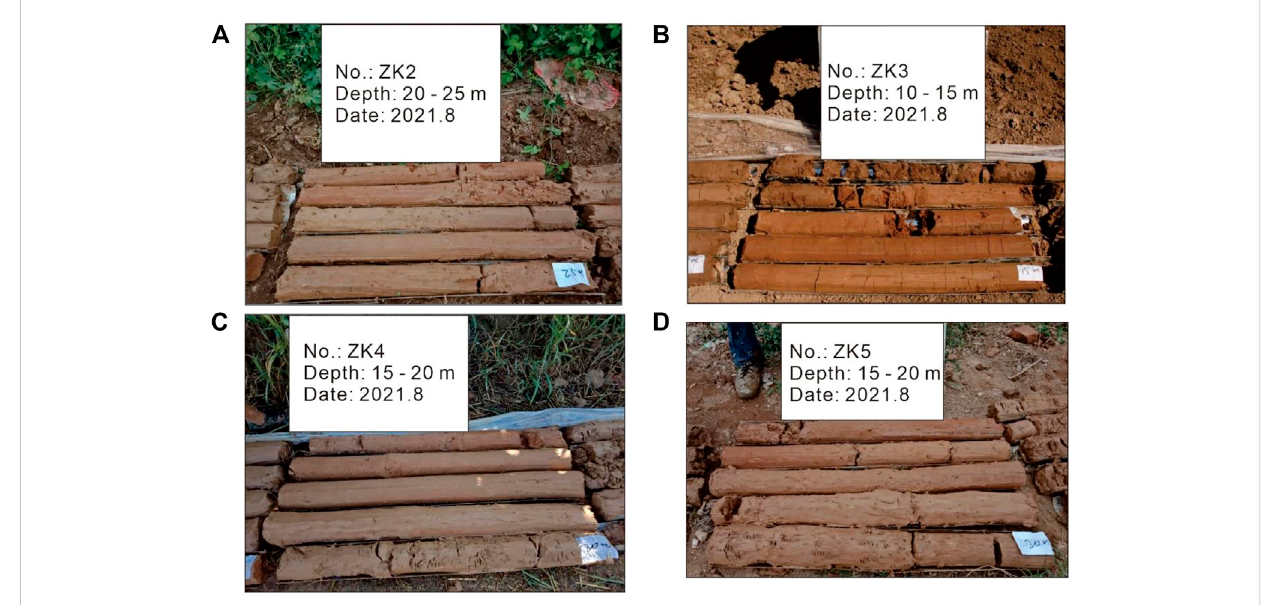
FIGURE 4 (A – D) Photographs of late Pleistocene paleosol strata (S 1 ) revealed by cores extracted from the boreholes. The contents inside the white panels donote the boreholes number, core depths and drilling dates, respectively.